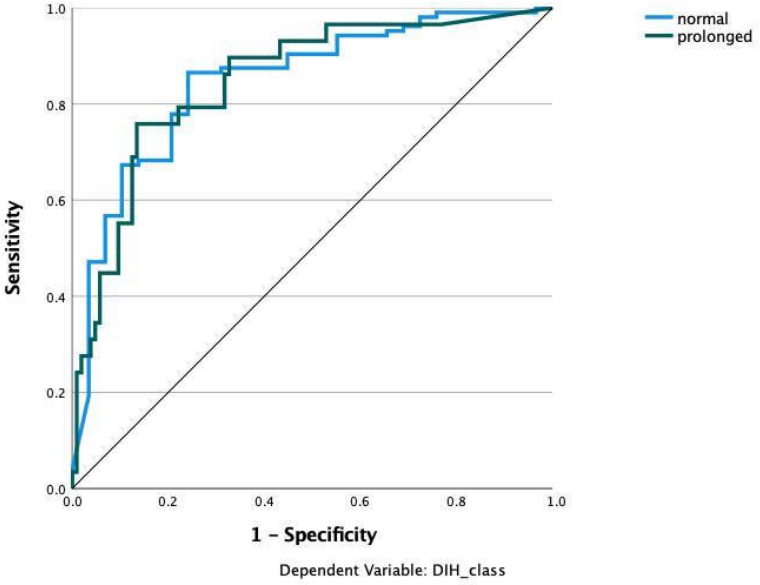
Figure 5. Prediction of hospital stay with radial basis function neural network (RBNN). Input layer: feature variables (22 units). Hidden Layer: 5 units, activation function softmax. Output layer: de ‐ pendent variable Hospital stay (2 units), activation function: identity, error function sum of squares. The number of units in the hidden layer was determined by the testing data criterion: the best num ‐ ber of hidden units is the one that yields the smallest error in the testing dataset. Train/Test/Valida ‐ tion split: 80/10/10. Percentage incorrect predictions on the training set 19.0%; percent incorrect pre ‐ dictions on testing set: 11.8%; percent incorrect predictions on holdout set: 16.7%. AUC: 0.847.